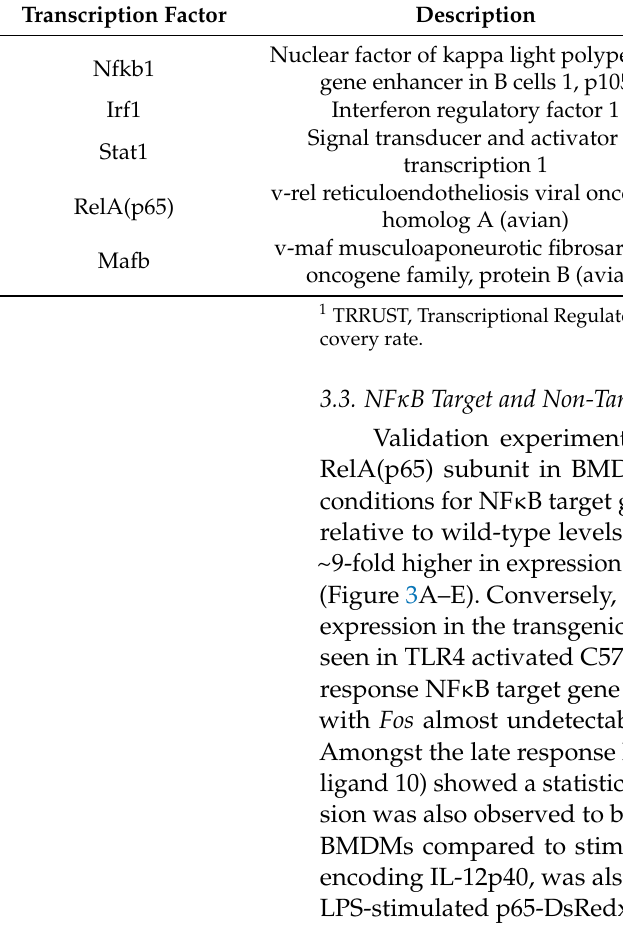
Table 1. Transcriptional regulatory relationships identified from the differentially expressed genes in bone marrow-derived macrophages (BMDMs) from p65-DsRedxp/I κ B α -eGFP transgenic mice. TRRUST 1 v.2 Database